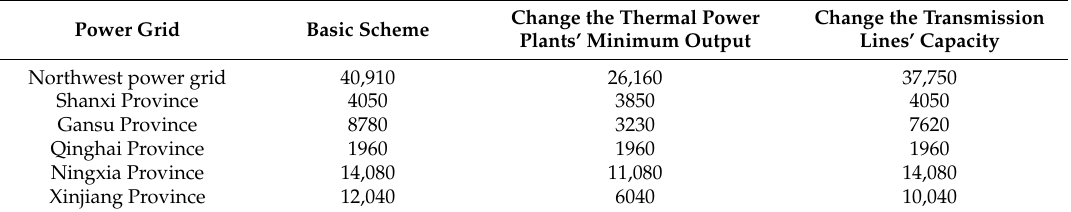
Table 4. Local accommodated power of wind power considering sensitivity analysis (MW).